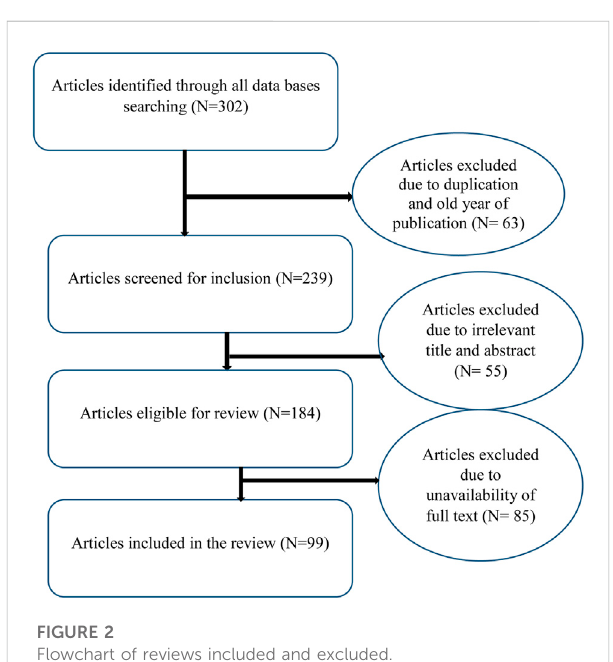
FIGURE 2 Flowchart of reviews included and